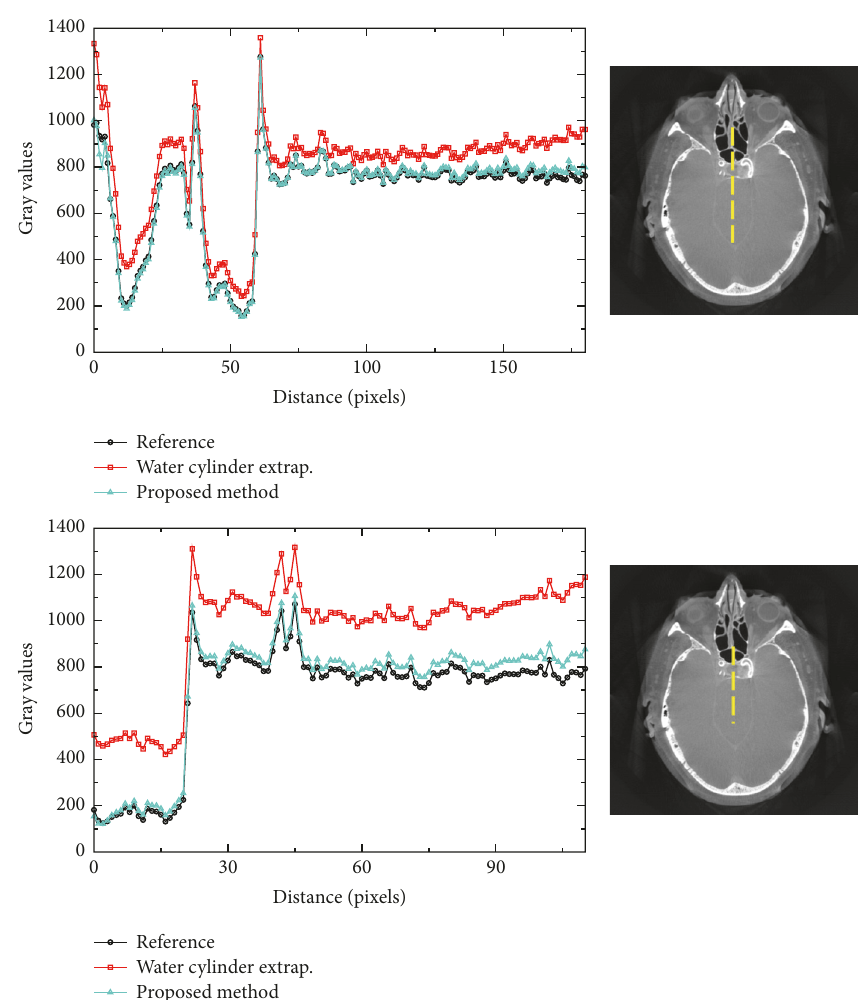
Figure 10: Plots of line profiles for each algorithm in the medium truncation case and in the severe truncation case for clinical dataset 1. The yellow dashed line in the corresponding right image indicates the position of the line